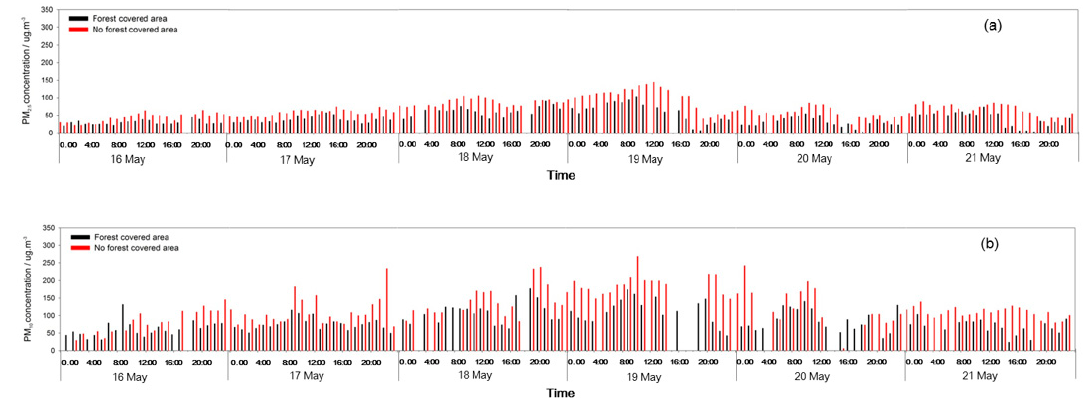
Figure 9. PM 2.5 ( a ) and PM 10 ( b ) concentrations changes in heavy pollution event.